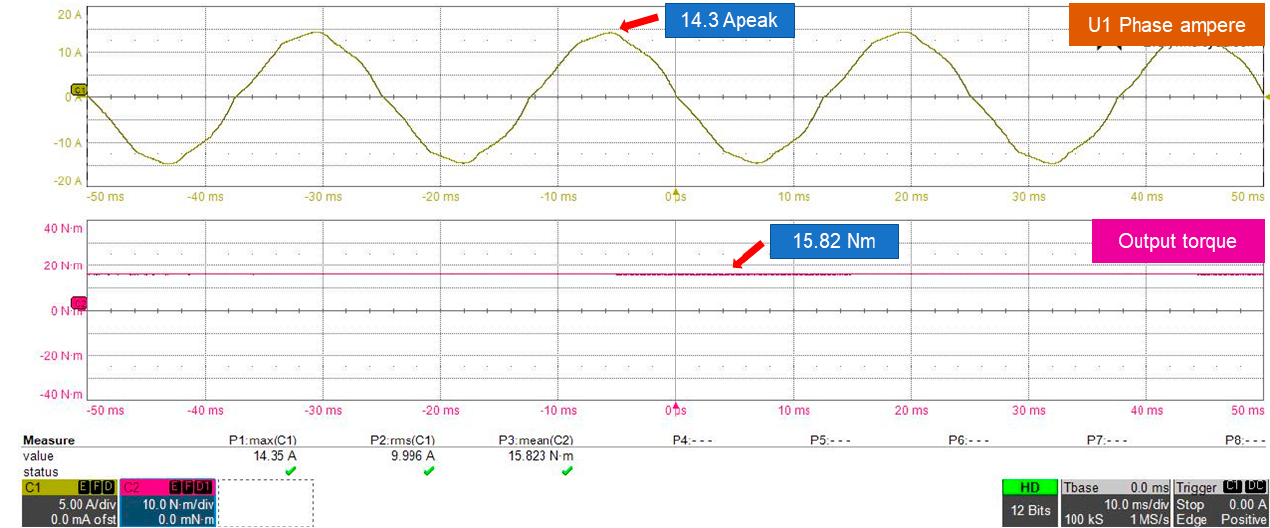
Figure 13. Torque curves at 480 r/min and 10 Arms for fundamental-controlled operation.